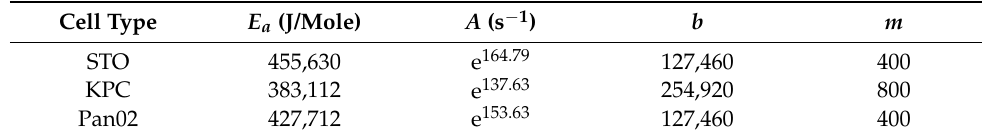
Table 2. Obtained Arrhenius coefficients for all three cell lines.